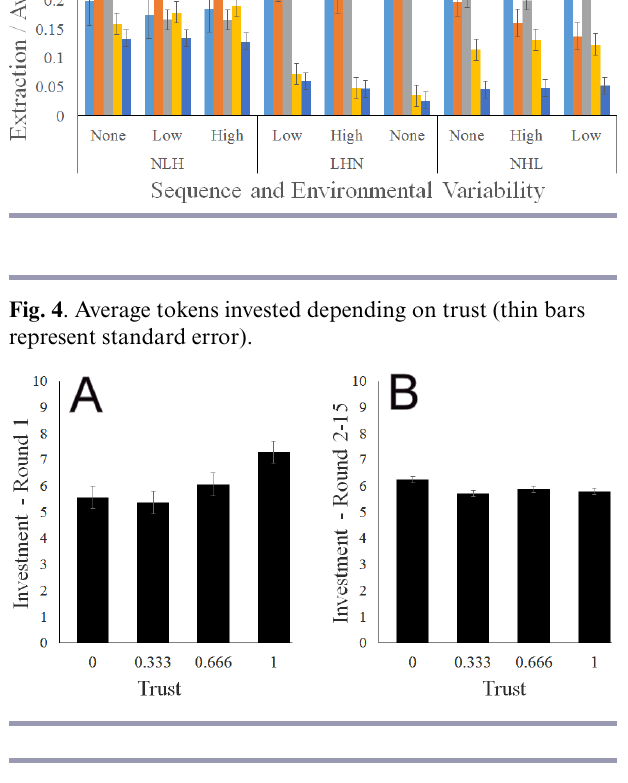
Fig. 5 . Average tokens invested depending on normalized risk score. Red line = Frequency of participants making specific choices risk choices (thin bars represent standard error).